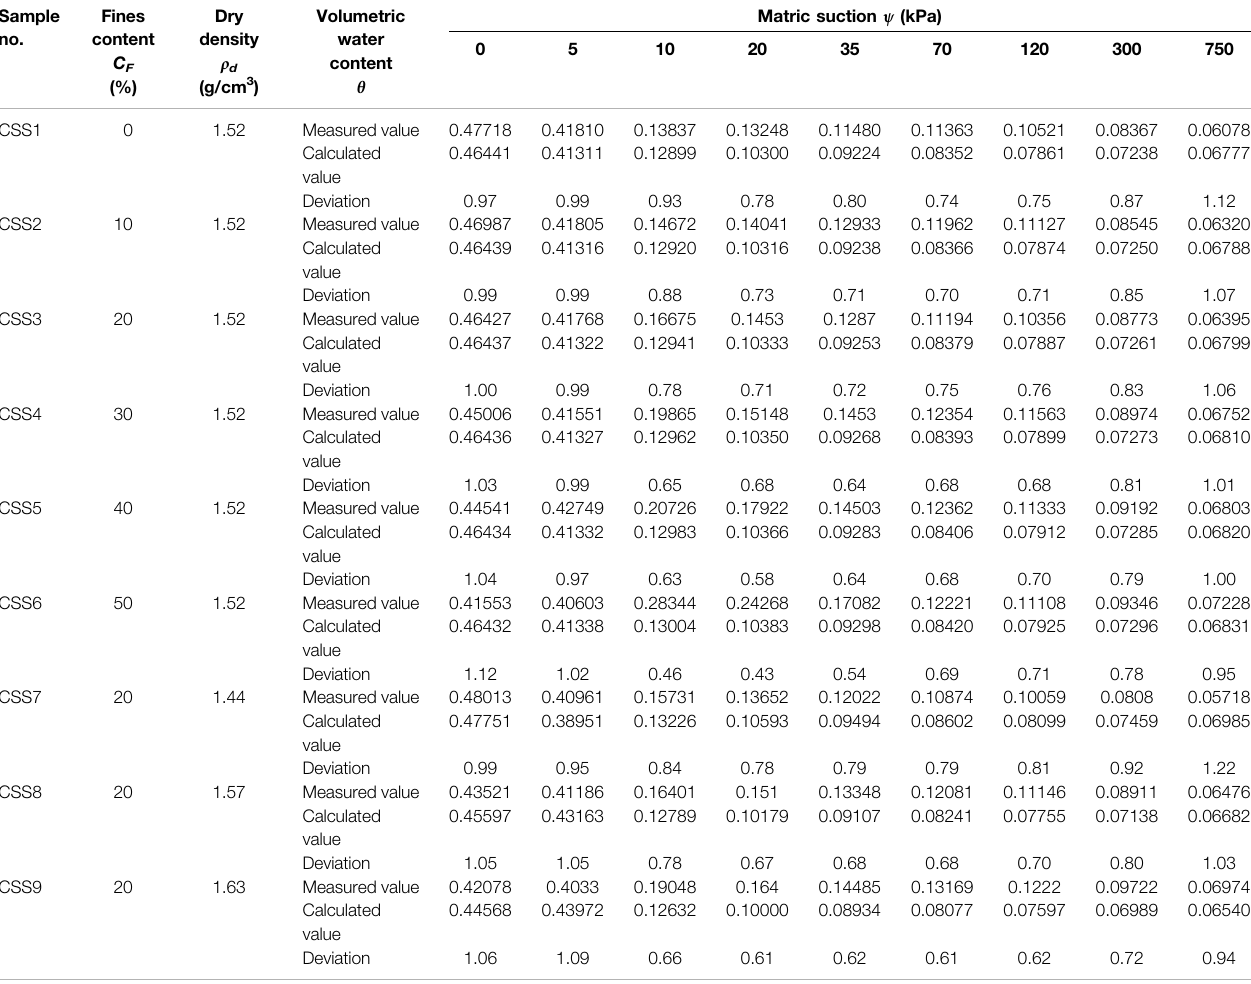
TABLE 5 | The comparison between the calculated and measured values for volumetric water content. Sample